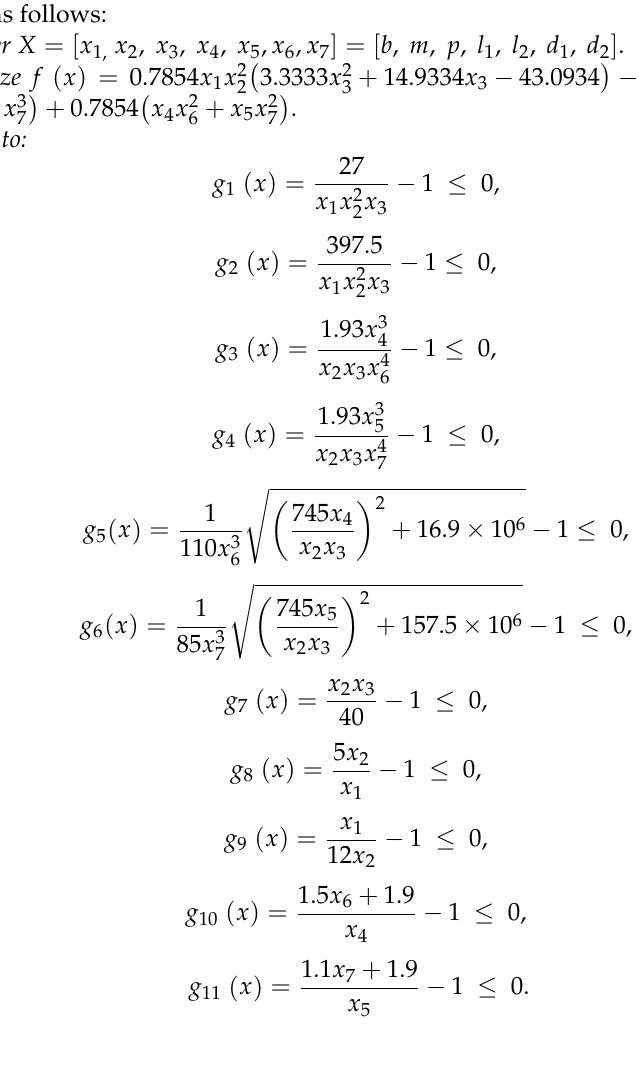
Figure 6. POA’s performance convergence curve on pressure vessel design.